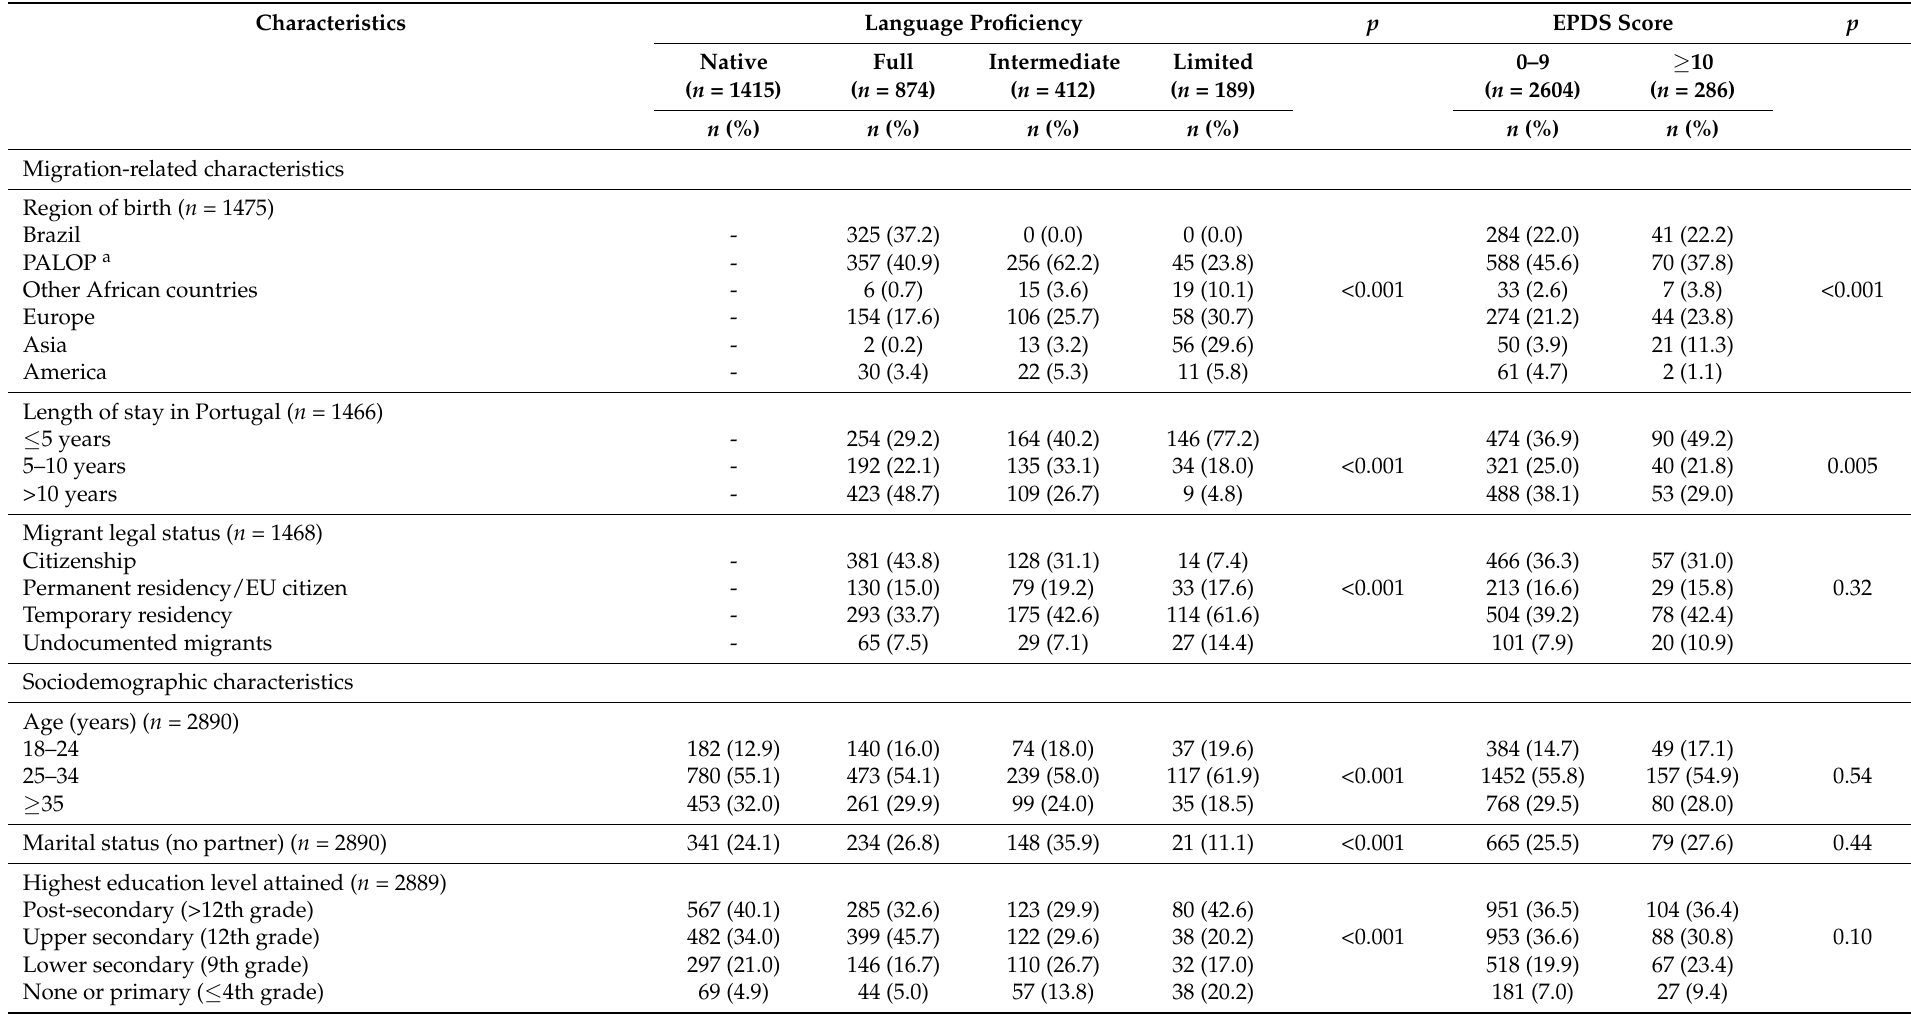
Table 1. Maternal characteristics by host-country language proficiency and EPDS score ( n =